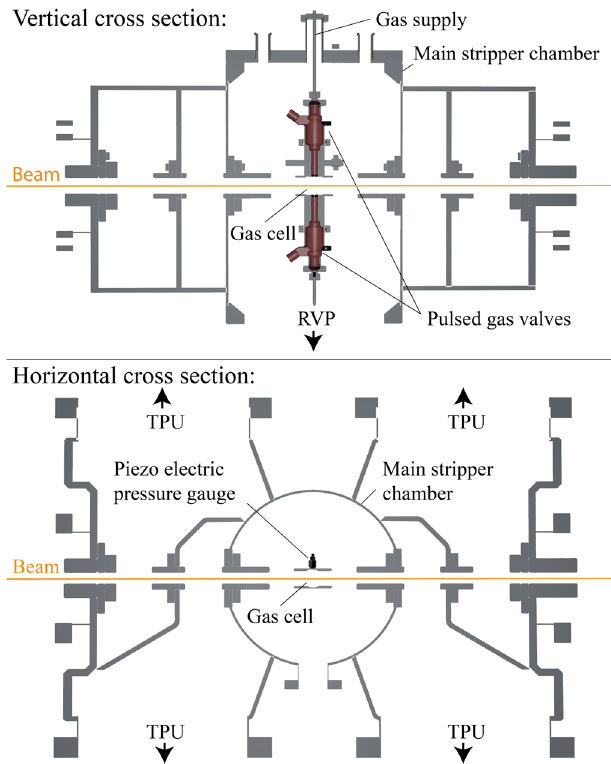
FIG. 2. Schematic cross-sectional views of the main gas- stripper section: (a) vertical and (b) horizontal. The gas cell for the stripping process is fed by two pulsed gas valves (red) positioned on top and on the bottom of the beam line in the main stripper chamber, which are supplied through the top flange. A four-stage differential pumping system is used, comprising a roots vacuum pump (RVP) below the main stripper chamber and four turbomolecular pumps (TPU) on the sides of the adjacent chambers. A piezoelectric pressure gauge is attached to the side of the gas cell to enable pressure